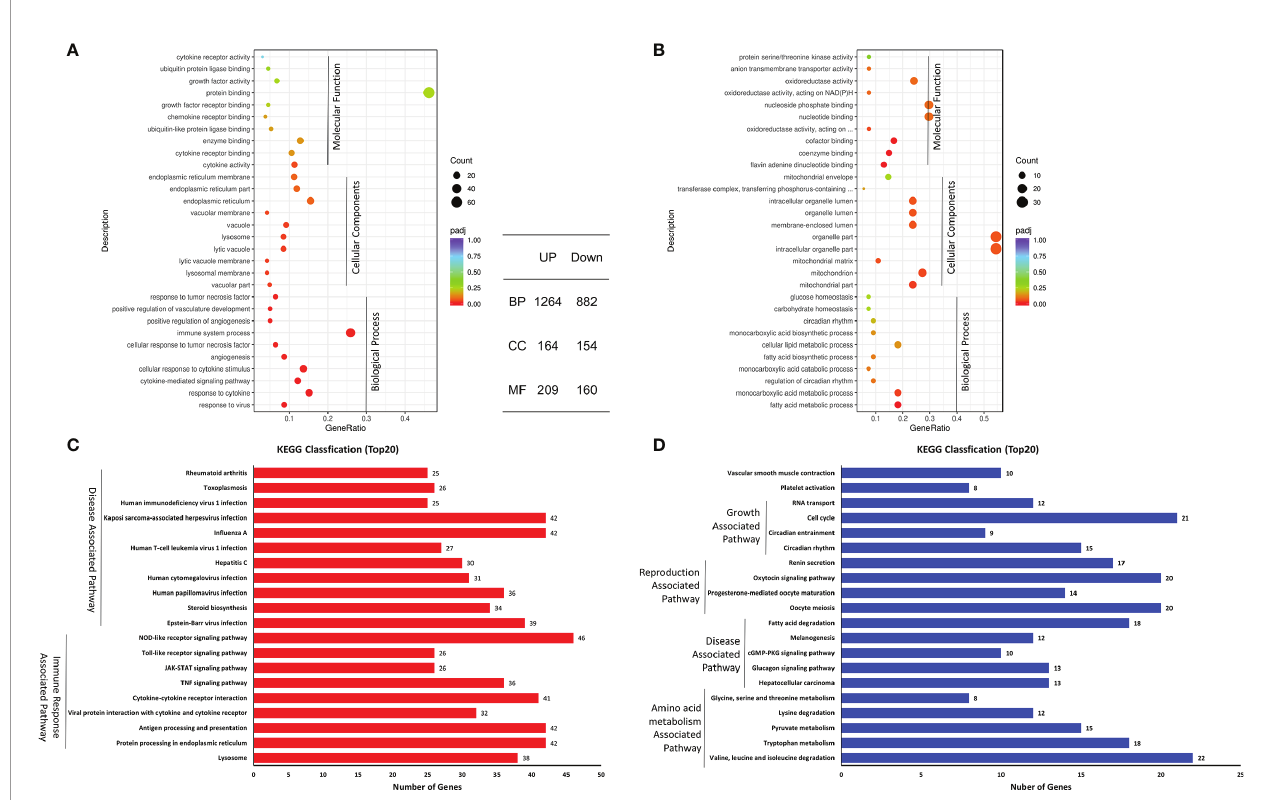
FIGURE 3 | Top 20 pathways of the shared DEGs. (A, B) GO annotation of up- (A) and downregulated (B) DEGs. (C, D) KEGG analysis of up- (C) and downregulated (D)